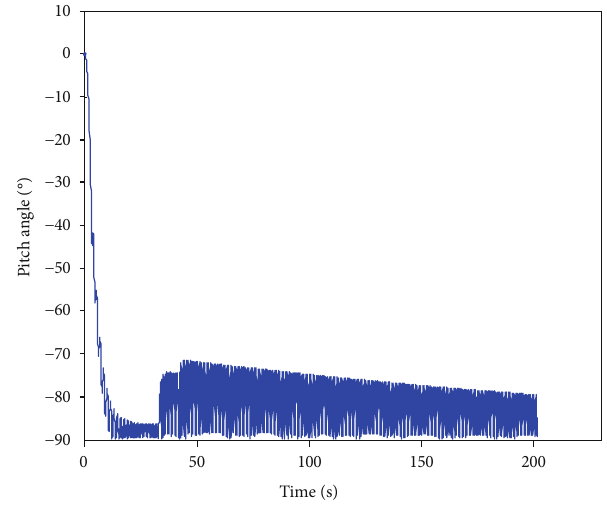
Figure 7: Pitch angle-time